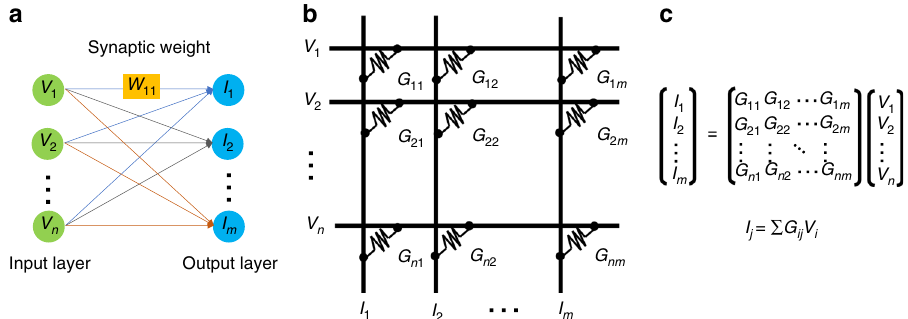
Fig. 1 Neuromorphic computing system based on NVM. a Schematic illustration of one-layer neural network with synaptic weights ( W ) connecting an input layer to an output layer. b A synaptic weight is represented by a conductance value of an NVM element at each cross-point in a crossbar array structure. c Vector-matrix multiplication is performed by sensing the current ( I ) for each column, which is the product of the synaptic weight ( G ) and the input signal ( V